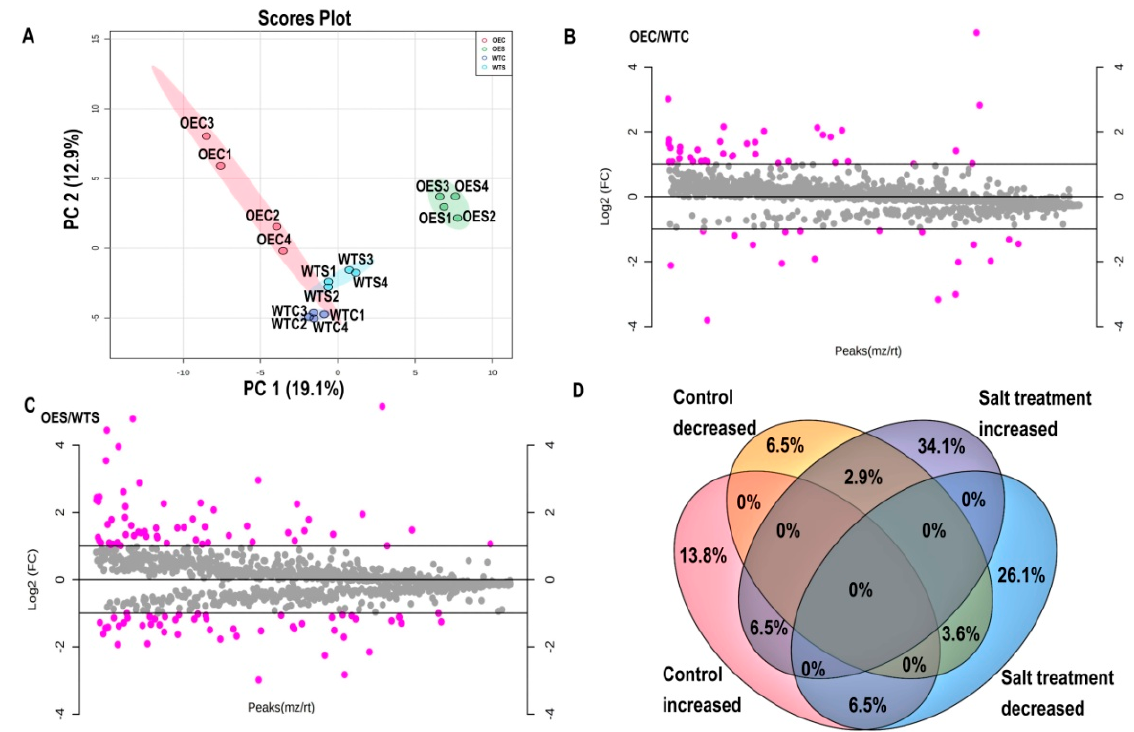
Figure 7. Differentially expressed proteins (DEPs) under control and salt stress treatment. WTC1-WTC4, four biological replicates of WT under control conditions; OEC1-OEC4, four replicates of OE plants under control conditions; WTS1-WTS4, four biological replicates of WT after salt stress treatment; OES1-OES4, four biological replicates of transgenic plants after salt stress treatment. ( A ) PCA result of all the control and salt stress samples of WT and McHB7 OE. ( B ) DEPs under control conditions. ( C ) DEPs under salt stress treatment. ( D ) Venn diagram of DEPs under control and salt stress treatment.